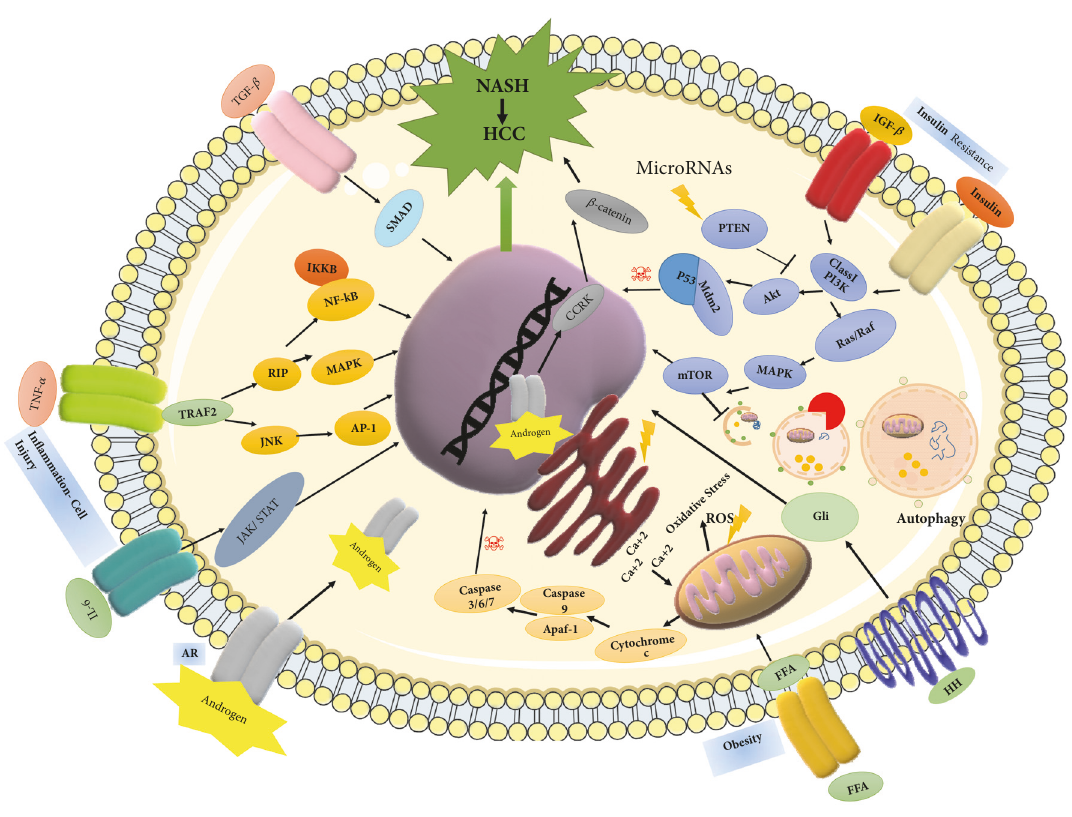
Figure 3: Molecular signaling pathways involved in NASH-related HCC.